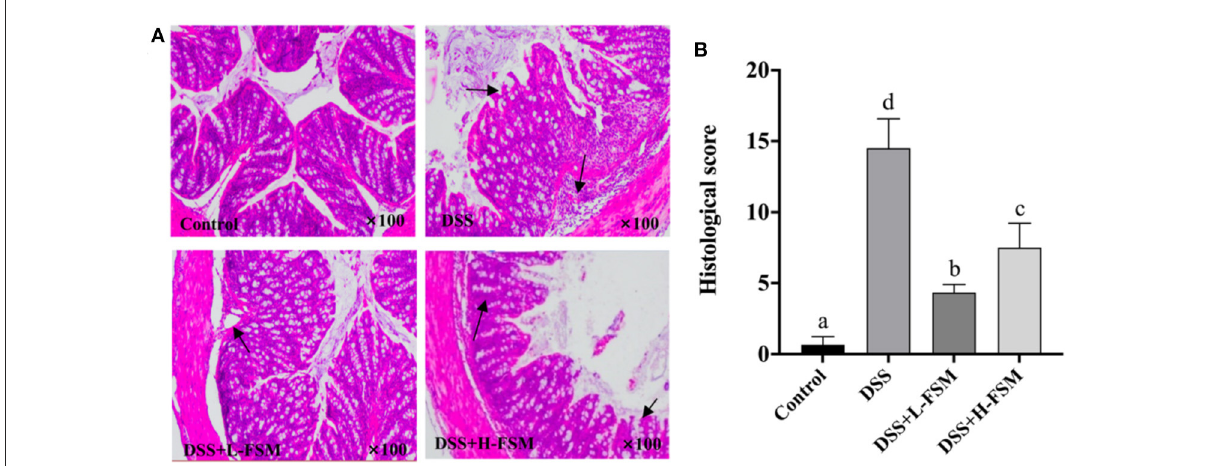
FIGURE8 Effect of fermented soymilk on DSS-induced intestinal lesion in mice. (A) Histological analysis on the colonic section ( n = 6 per group); The black arrows indicate inflammatory cell infiltration. (B) Histological score of the colonic section ( n = 6 per group). (a–d) Different letters indicate significant differences between groups according to Tukey’s HSD test ( p <